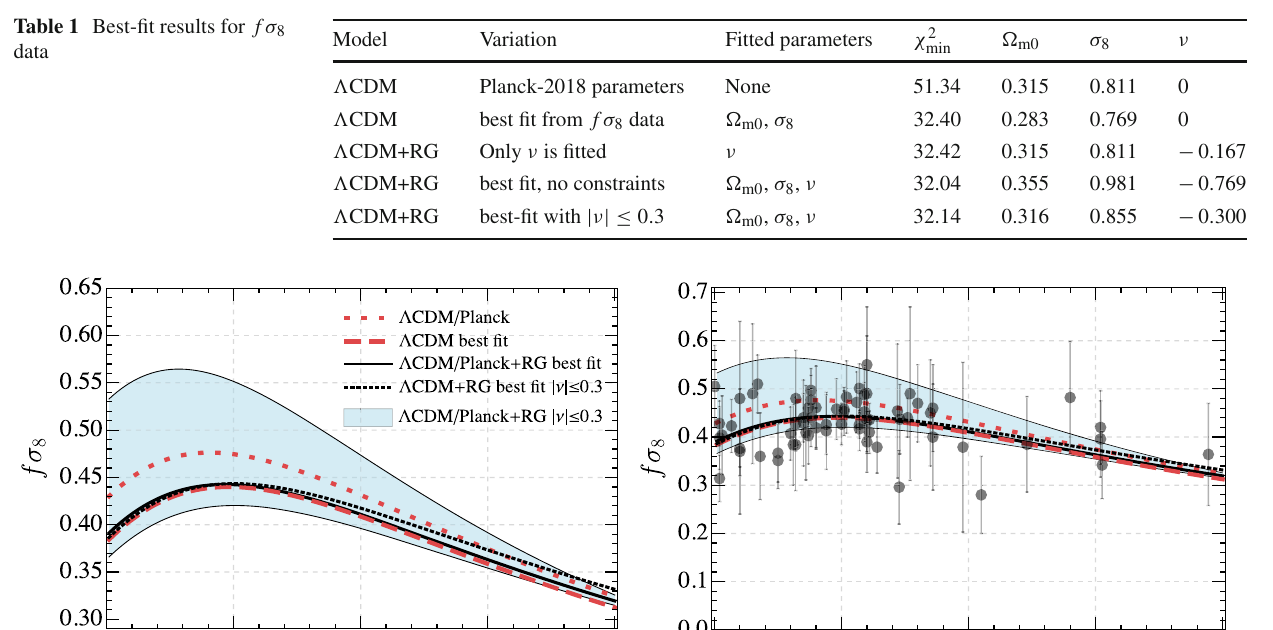
bluish region shows the effect of changing the value of ν , within the allowed bounds (94), while using the values of (cid:24) m 0 and σ 8 given by (cid:4) CDM/Planck [55]. Right: This plot shows the same curves displayed in the left plot and it adds the f σ 8 observational data (data compiled by Ref.